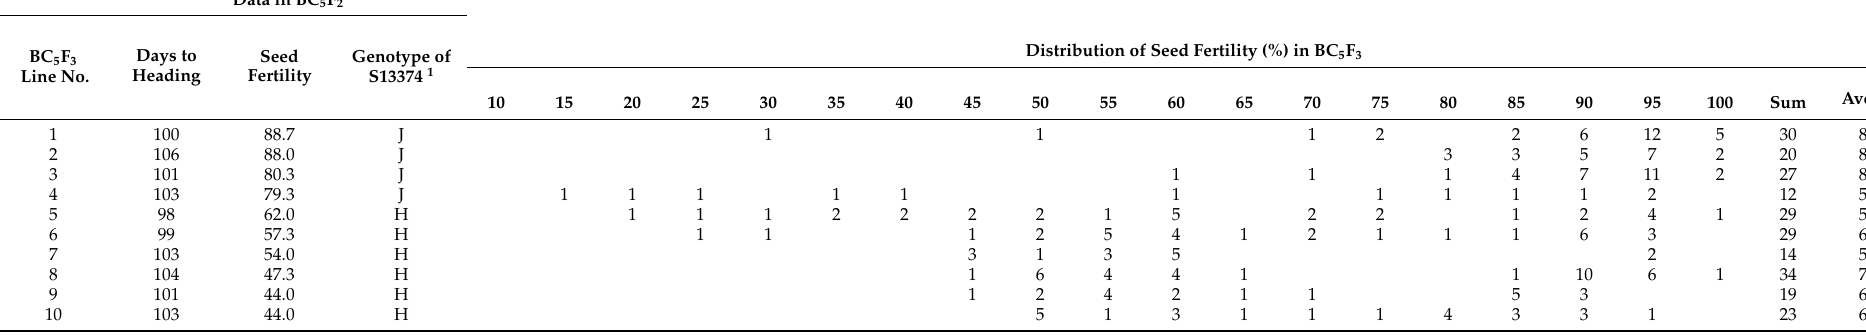
Table 1. Frequency distribution of seed fertility in BC 5 F 3 generation using T65 as the recurrent parent and Jpn2 as the donor parent.